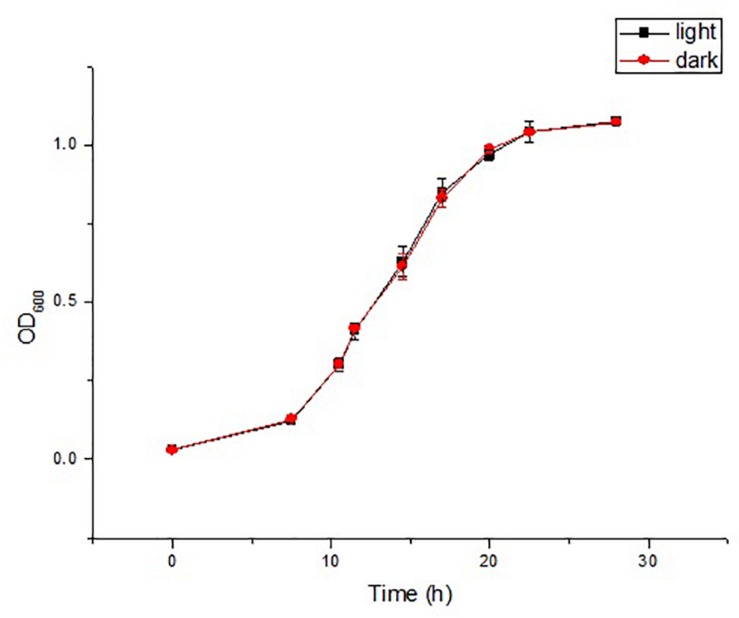
Time courses of cell growth (OD600) in the strain YLOS41T under dark or light conditions (n = 3).